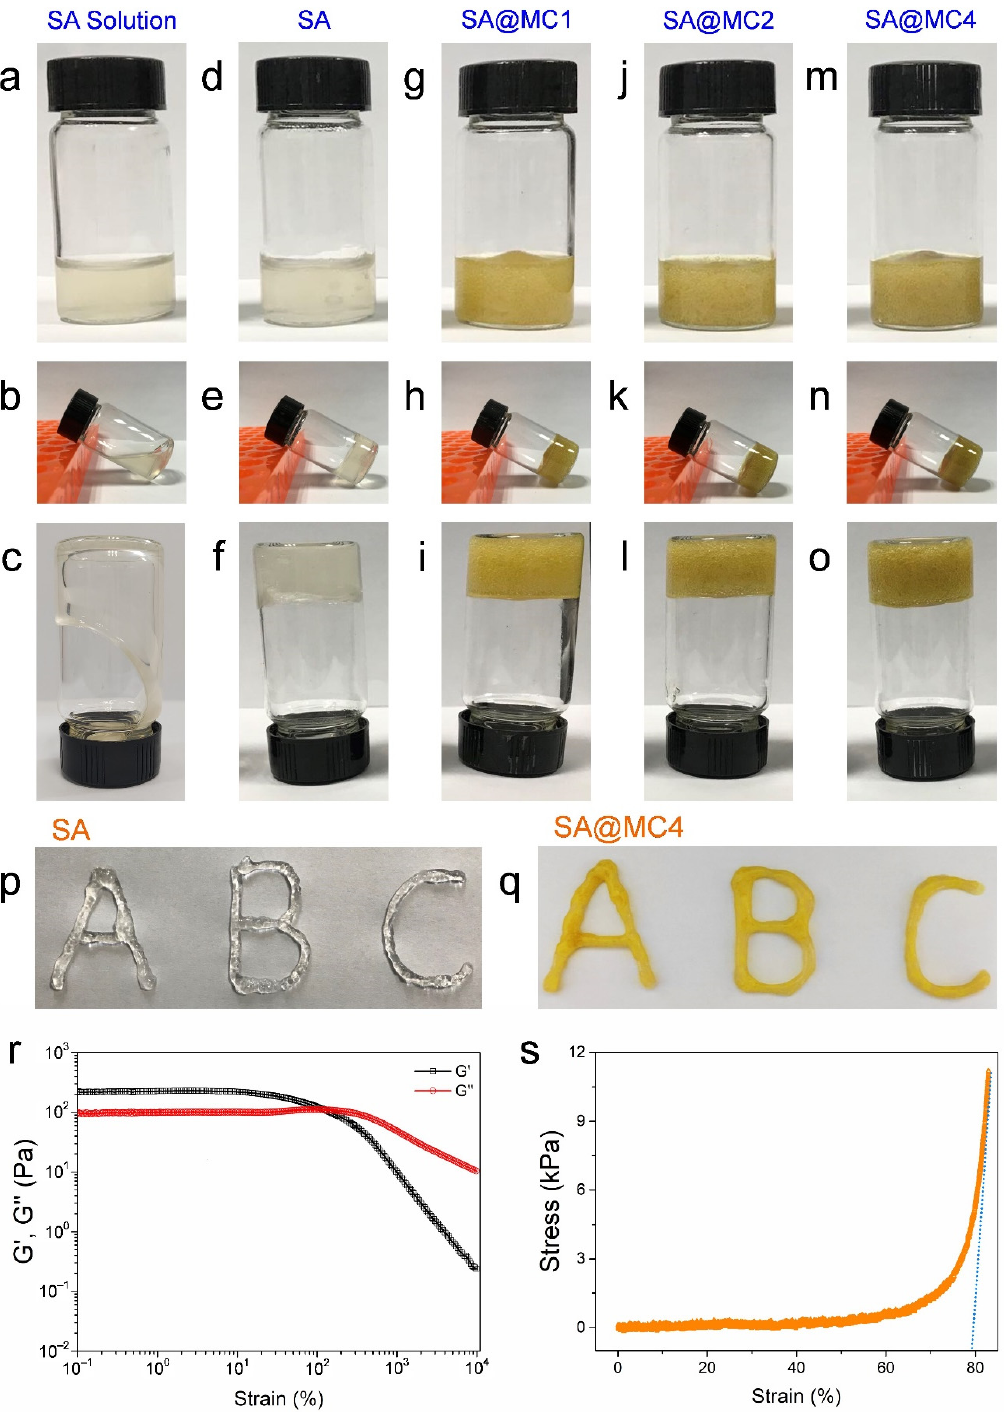
Figure 1. Injectable property of SA@MC hydrogel. ( a – c ) SA solution before Ca 2+ crosslinking; ( d – f ) SA hydrogel; ( g – i ) SA@MC1 hydrogel; ( j – l ) SA@MC2 hydrogel; ( m – o ) SA@MC4 hydrogel; ( p , q ) the injectable property of SA and SA@MC4 hydrogels; ( r ) the G ′ and G ″ of the SA@MC4 on the strain amplitude sweep (c = 0.1–10,000%) at a fixed frequency (f = 1 Hz); ( s ) the tensile stress–strain curve of SA@MC4 injectable hydrogel.